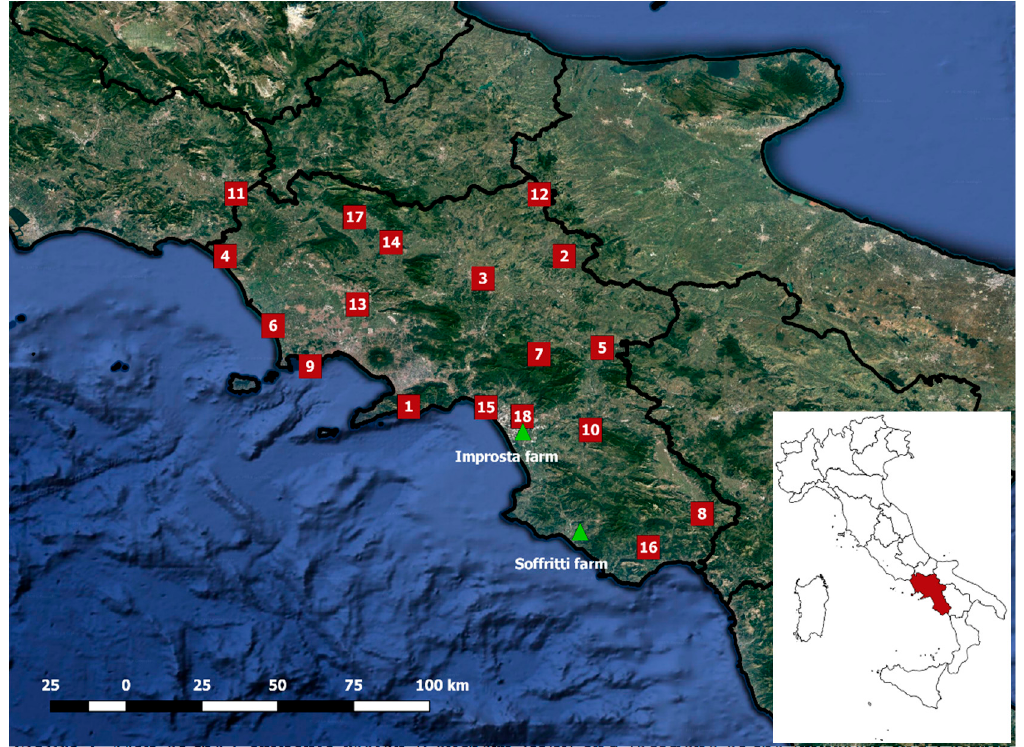
Figure 1. Map of the Campania region (Southern Italy) and locations of the Improsta and So ff ritti farms (green triangles) and ground automatic weather stations (red